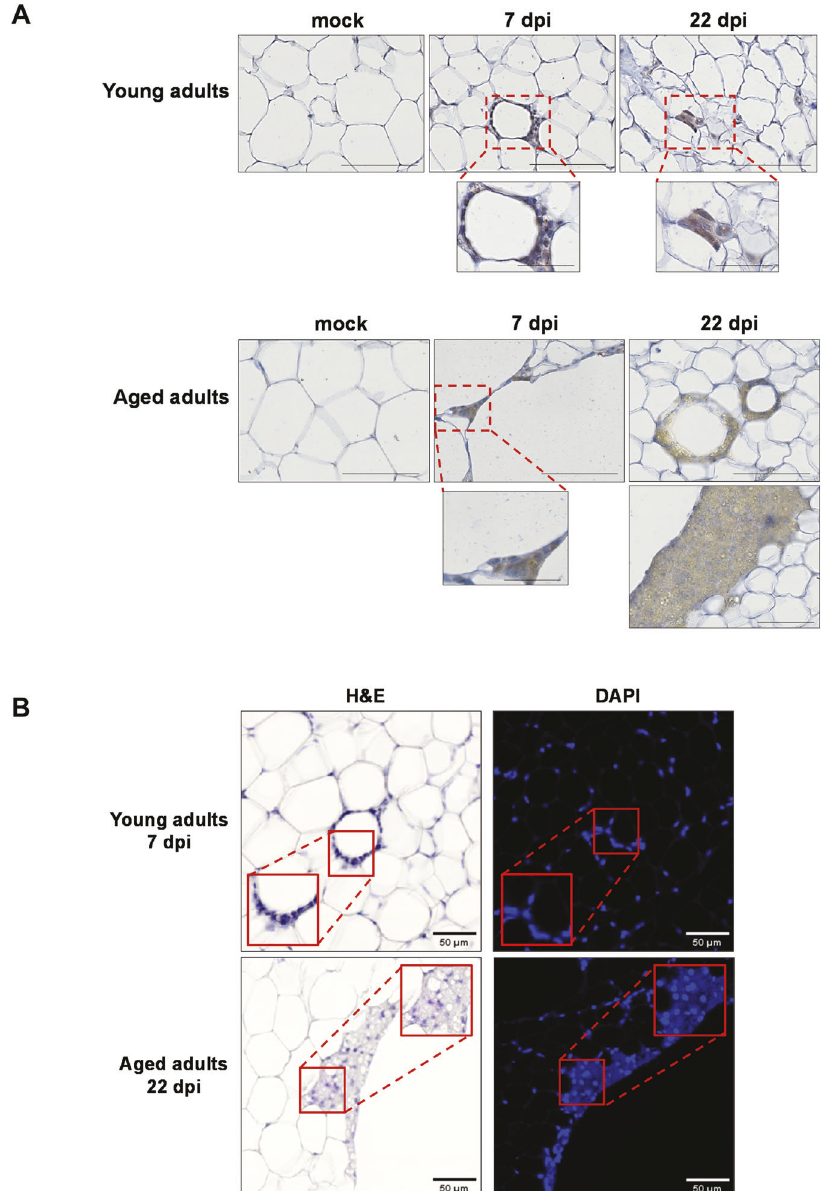
Fig. 5 In the SCAT of golden hamsters, the macrophages around dead adipocytes are infected with SARS-CoV-2 and formed syncytia. A Representative IHC staining for SARS-CoV-2 spike protein (brown precipitate) in the (inguinal) SCAT of young-adult and aged hamsters at 0 (mock), 7 and 22 dpi (scale bars = 100 μ m). Higher magni fi cation images of CLSs are shown (scale bars = 50 μ m). Slides were counterstained with Mayer ’ s hematoxylin. B The same CLSs found in the (inguinal) SCAT of young-adult and aged hamsters at, respectively, 7 and 22 dpi, were H&E-stained (left panels) or DAPI-stained (right panels) (scale bars = 50 μ m). In left panels, the blue fl uorescence indicates DAPI staining for cell nuclei, and higher magni fi cations are shown that revealed the presence of multinucleated